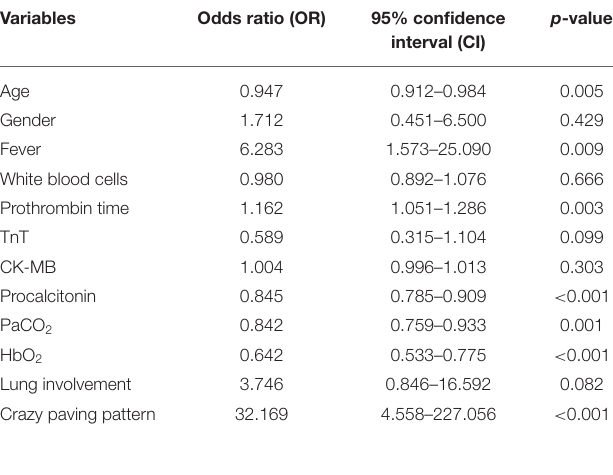
TABLE 5 | Multivariate analysis of independent risk factors for differentiating COVID-19 ALI from non-COVID-19 ALI cases.